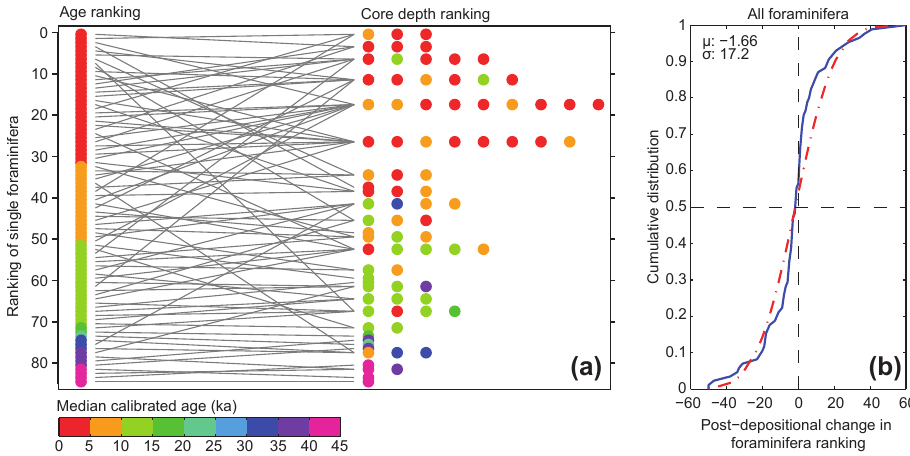
Figure 4. (a) Visualisation of PDSM in core T86-10P. Single C. wuellerstorfi benthic foraminifera (represented by coloured dots coded by median age) from core T86-10P are ranked by median calibrated age and by core depth. Single foraminifera recovered from the same core depth interval are given the same core depth ranking. Grey lines visualise the reconstructed post-depositional change in ranking. (b) Cumulative distribution plot of ranking change (as ascertained from a ) for single C. wuellerstorfi benthic foraminifera. The blue line represents an empirical cumulative distribution of the ranking change data. The broken red line represents a fitted normal cumulative distribution function (CDF) based on the mean and standard deviation of the ranking change data. Kolmogorov–Smirnov (K-S) testing is used to test a null hypothesis of the fitted normal distribution being similar to the empirical data. Hence, a P value greater than 0.05 (i.e. not less than or equal to) indicates normal distribution of the data at the α = 0 . 05 significance level. K-S test result: P = 0 . 047; not greater than